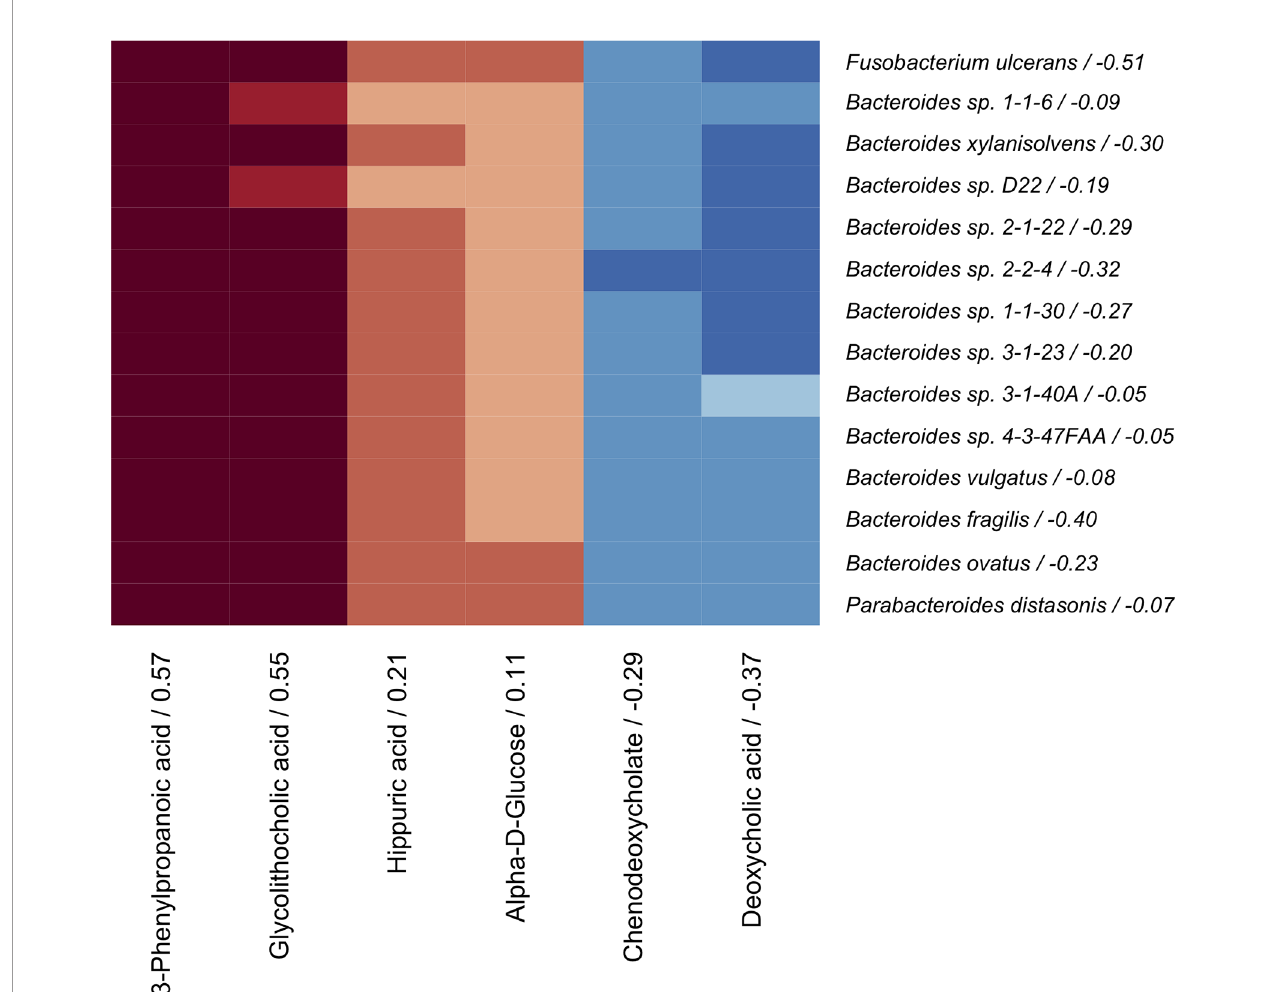
FIGURE 3 | Correlation heatmap of sCCA selected microbes (rows) and metabolites (columns) that are correlated with each other and with BMD. Canonical loadings are provided for each feature, which represent the contributions to the inter-omics relationship. Positive correlations are represented by blue, negative correlations are shown in red, and intensity of the color represents the strength of